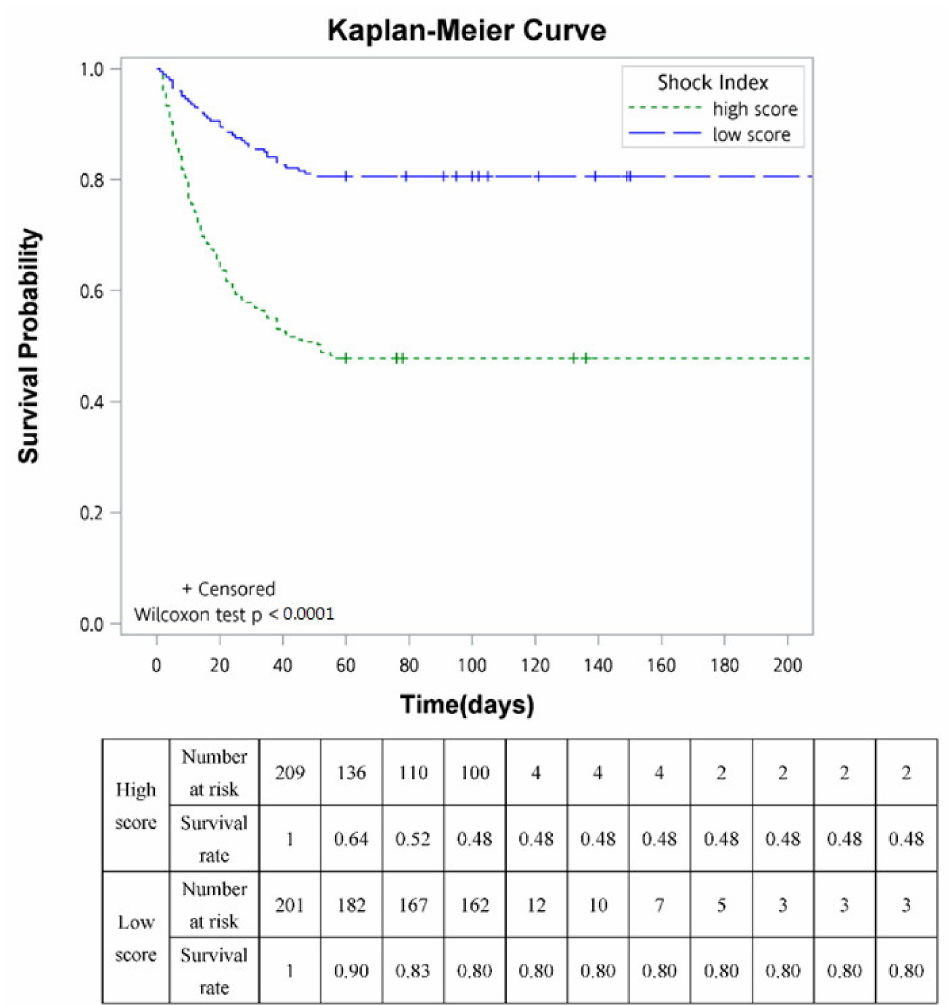
Figure 2. Kaplan-Meier curves of 60-day mortality for advanced cancer patients with SI> 0.94 (high score) and SI< 0.94 (low